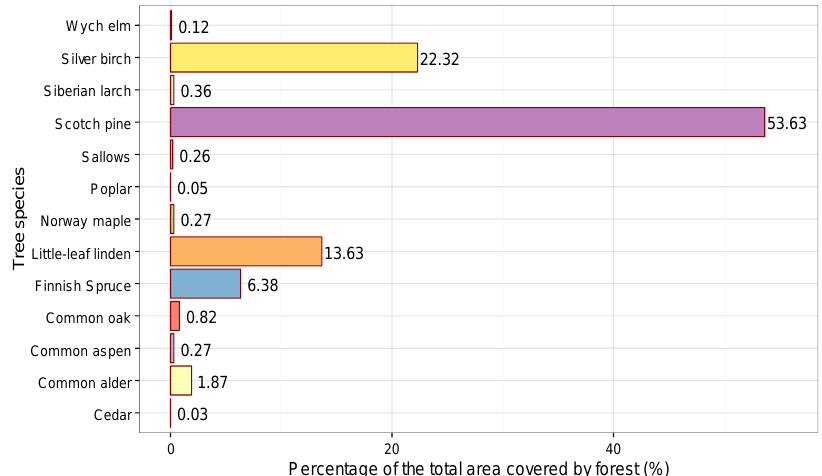
Figure 3. The abundance of tree species in the Raifa forest.